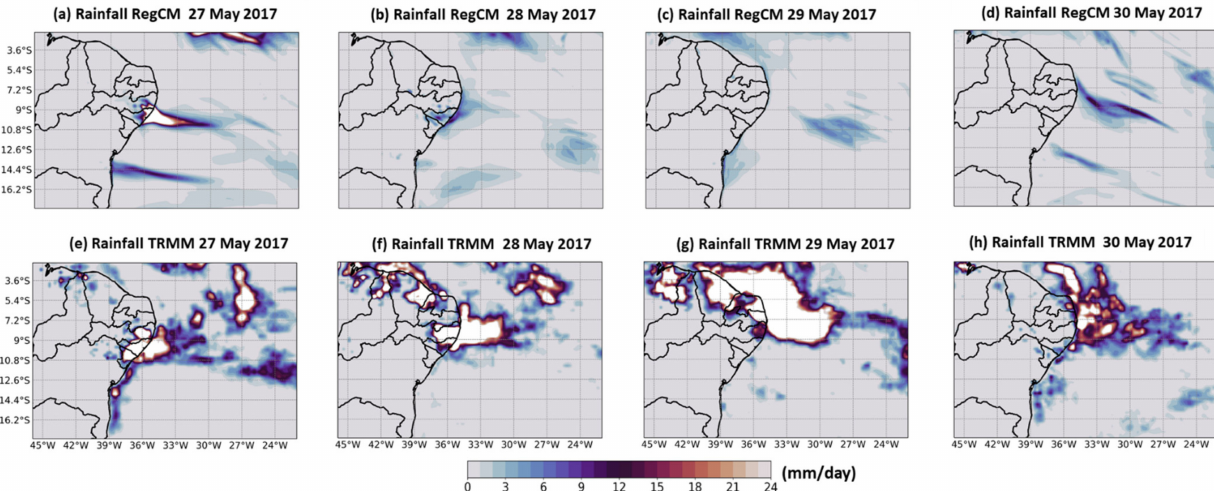
Figure 15. Spatial patterns of daily rainfall at the ECNEB during the period from 27 to 30 May 2017. The images ( a – d ) correspond to rainfall simulated by the RegCM model. The images ( e – h ) correspond to the rainfall obtained by the TRMM